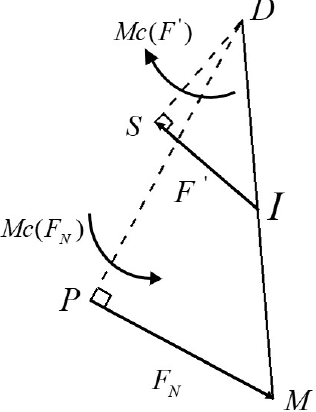
Figure 3. The force analysis model of the clamping